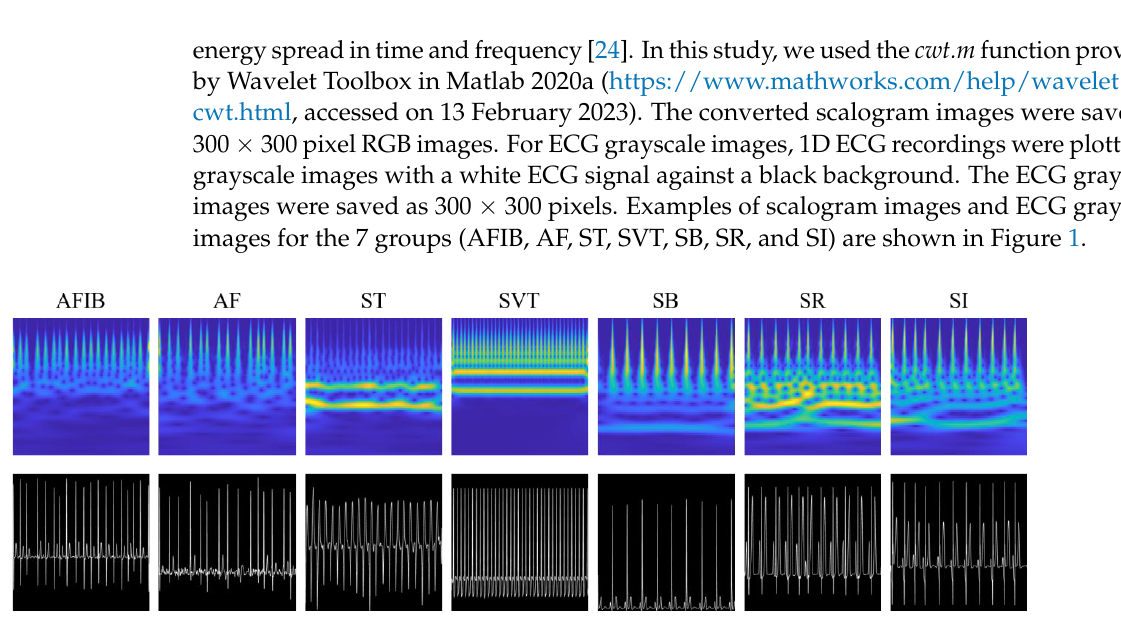
Figure 1. Sample images of scalogram and ECG grayscale images for the 7 groups of ECG recordings (AFIB, AF, ST, SVT, SB, SR, and SI). Each column represents the AFIB, AF, ST, SVT, SB, SR, and SI categories. The first row shows scalogram images and the second row displays grayscale images of the ECG signals.